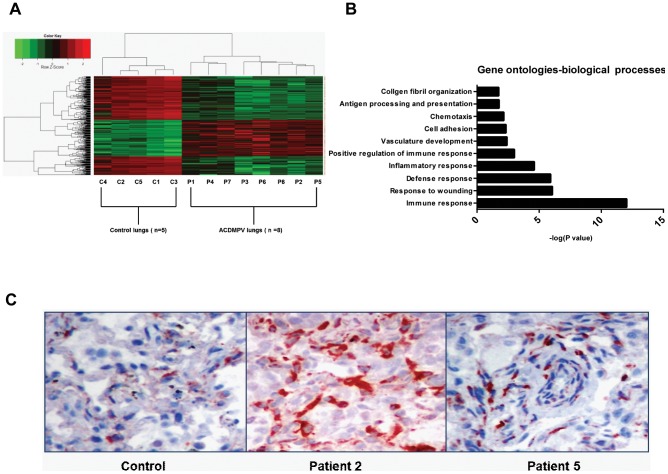
ACDMPV lung microarray analysis: heat map, clustering, DAVID analysis, and IHC validation.(A) Heat map for genes differentially expressed (adjusted p-value <0.05, fold change approximately >/ =  2 or </ =  − 2) between ACDMPV lungs (n  = 8) and control lungs (n = 5); Decreased gene expression is shown in green and increased gene expression is shown in red. (B) Top significant gene ontology (biological processes) terms associated with deregulated genes identified by DAVID analysis. (C) IHC validation for COL1A1; Representative slides from two patients' and one control sample at 20× magnification. A commercial control lung sample C5 clustered with the age-matched control lung samples C1-4. A lung sample from a patient who died from a different congenital diffuse lung developmental disorder was also included in the analysis. The deregulated genes in this sample clustered differently than those in ACDMPV lung samples (data not shown), confirming the validity of our approach.